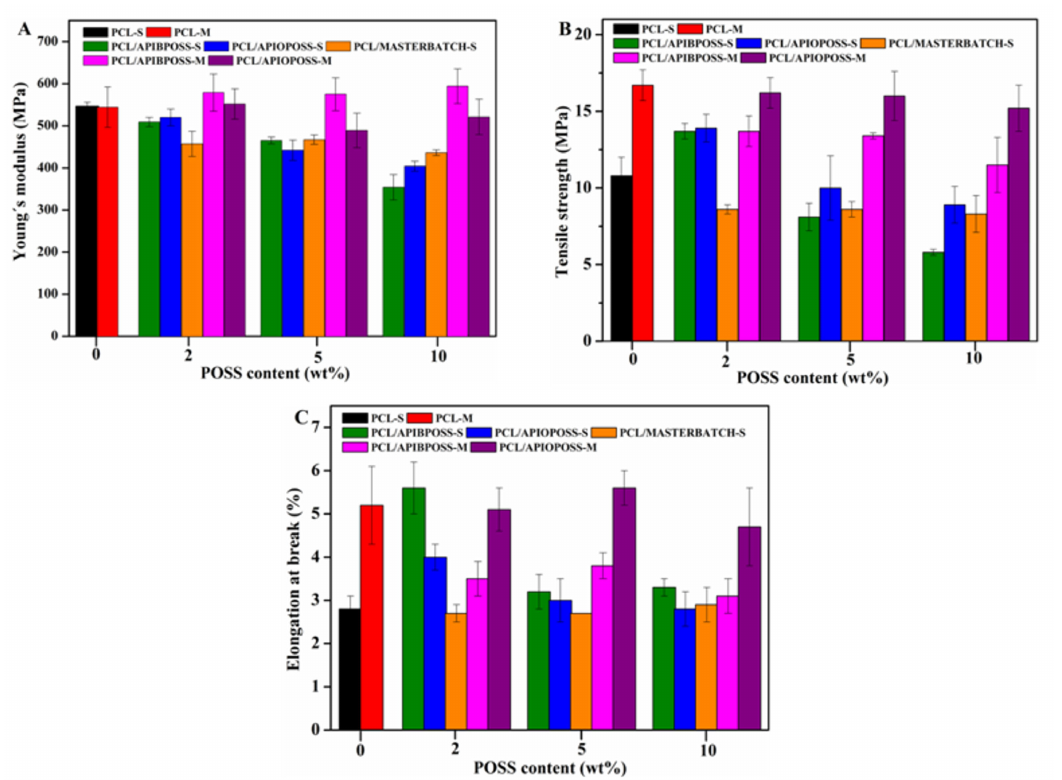
Figure 10. Mechanical properties of PCL/POSS nanocomposite films: ( A ) Young´s modulus; ( B ) Tensile strength; and ( C ) Elongation at